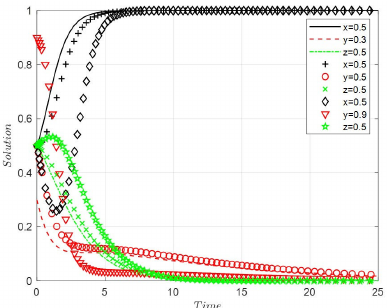
Figure 4. The evolutionary path of scenario